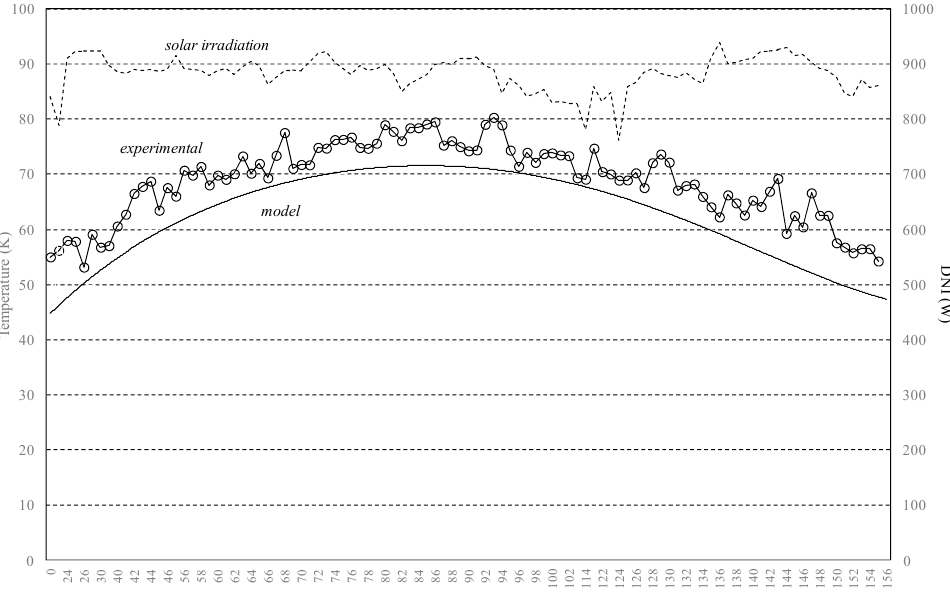
Figure 14. Theoretical and experimental comparison for a sunny day corresponding to the superior part of the tube.